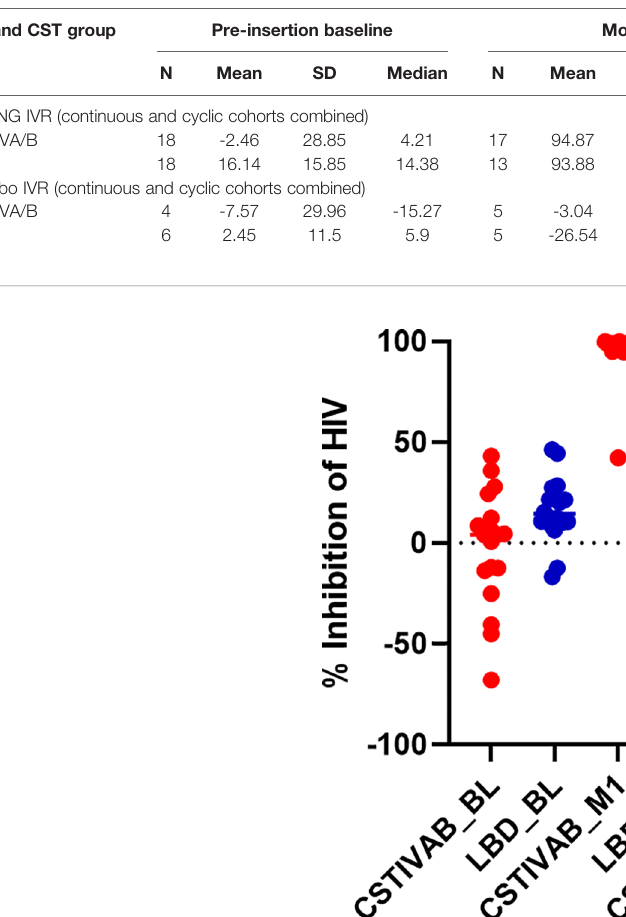
TABLE 4 | Change from baseline in HIV inhibition by vaginal fl uid based on IVR and community state type (CST).